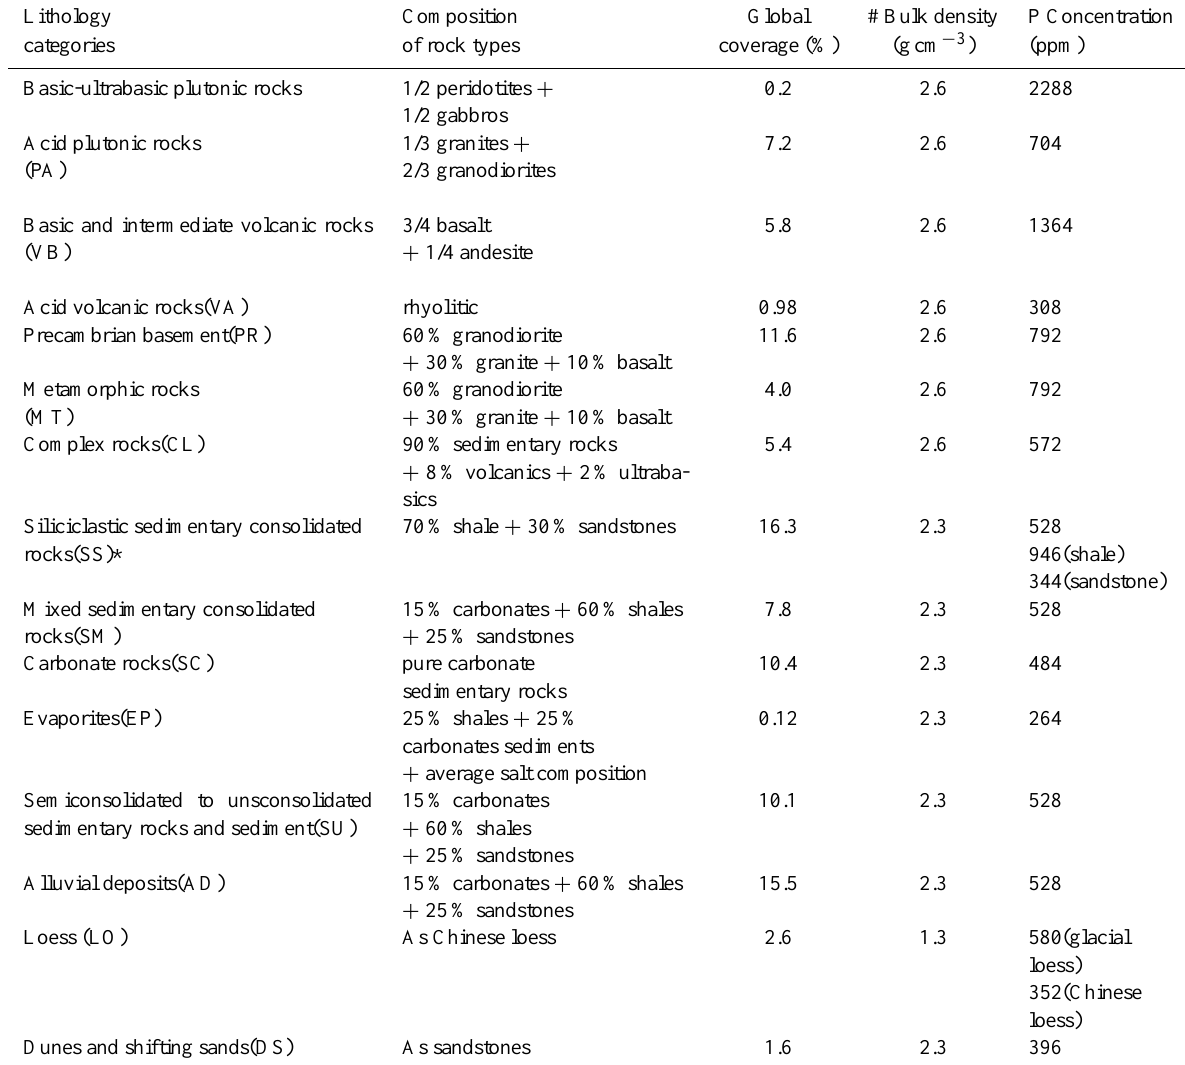
Table 1. Average concentration of P in different types of parent materials (apatite P).